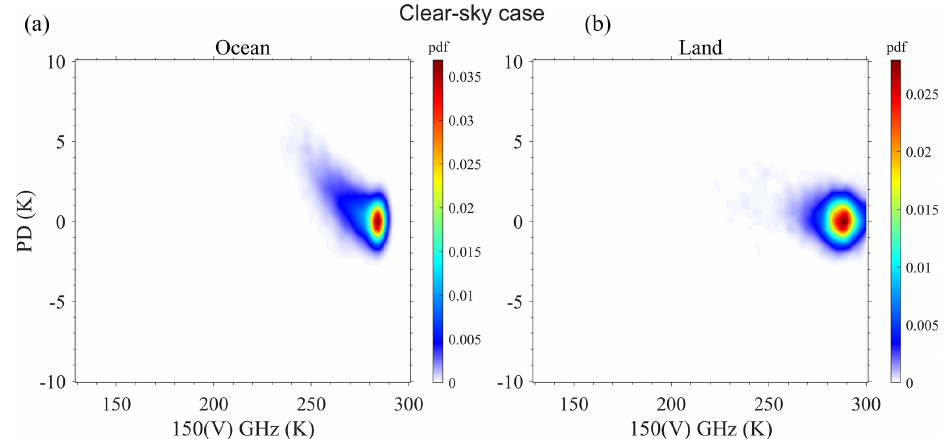
Figure 7. Same as Fig. 6 but for clear-sky